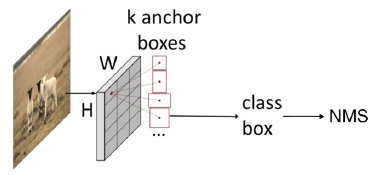
Fig. 8 One-stage